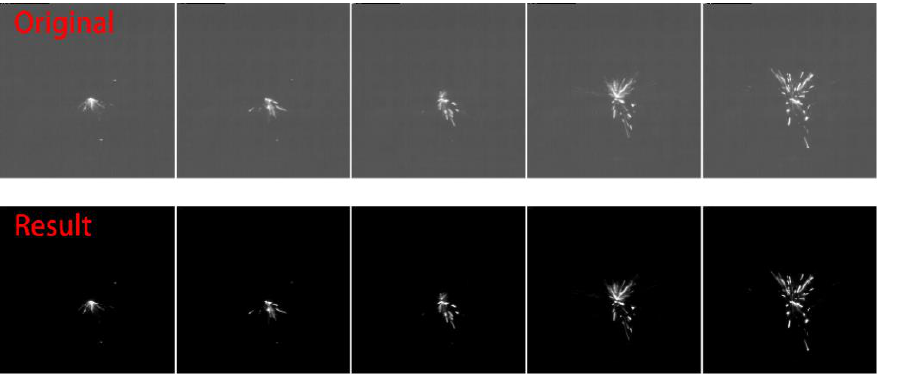
Figure 11. Filter result.